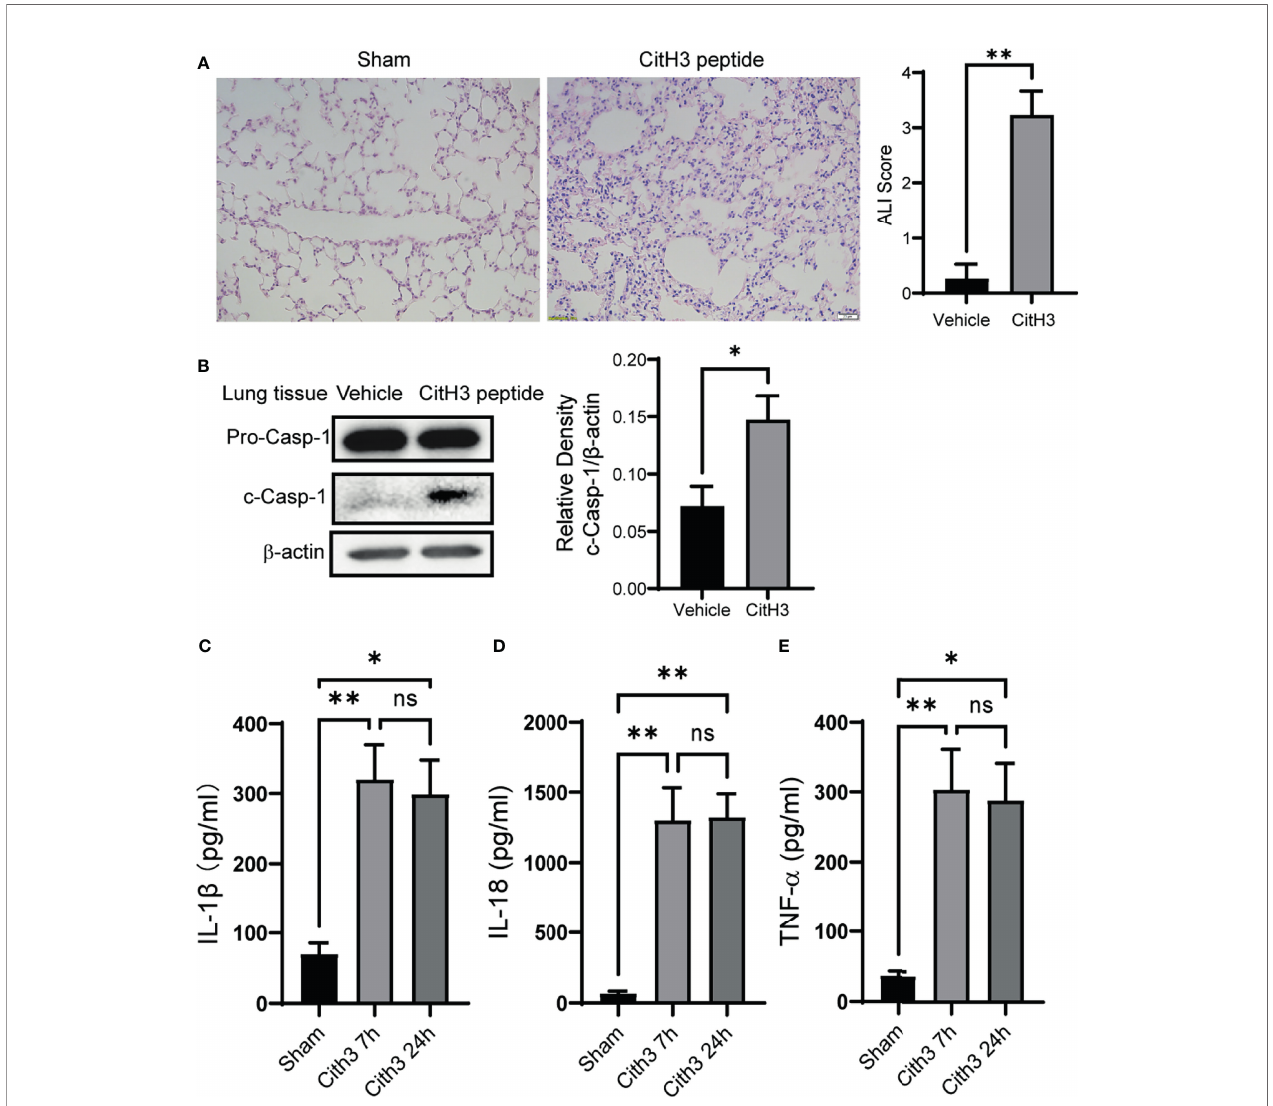
FIGURE 3 | Intravenous injection of CitH3 induces Caspase-1 activation in lung tissue. (A) Representative histology images of murine lungs and ALI score following H&E staining in Sham and CitH3 treatment group. (B) Representative Western blot images and densitometry quanti fi cation of activation of Caspase-1 in mouse lung tissue with or without CitH3 peptide challenging (n = 3/group). Concentrations of (C) IL-1 b , (D) IL-18, and (E) TNF- a in the BALF in mouse after i.v. injection of CitH3 peptide at 0 h, 7 h, and 24 h (n = 4/group). Data are expressed as mean ± SEM. *P < 0.05, **P < 0.01. i.v., intravenous; ns, not signi fi cant, SEM, standard error of the